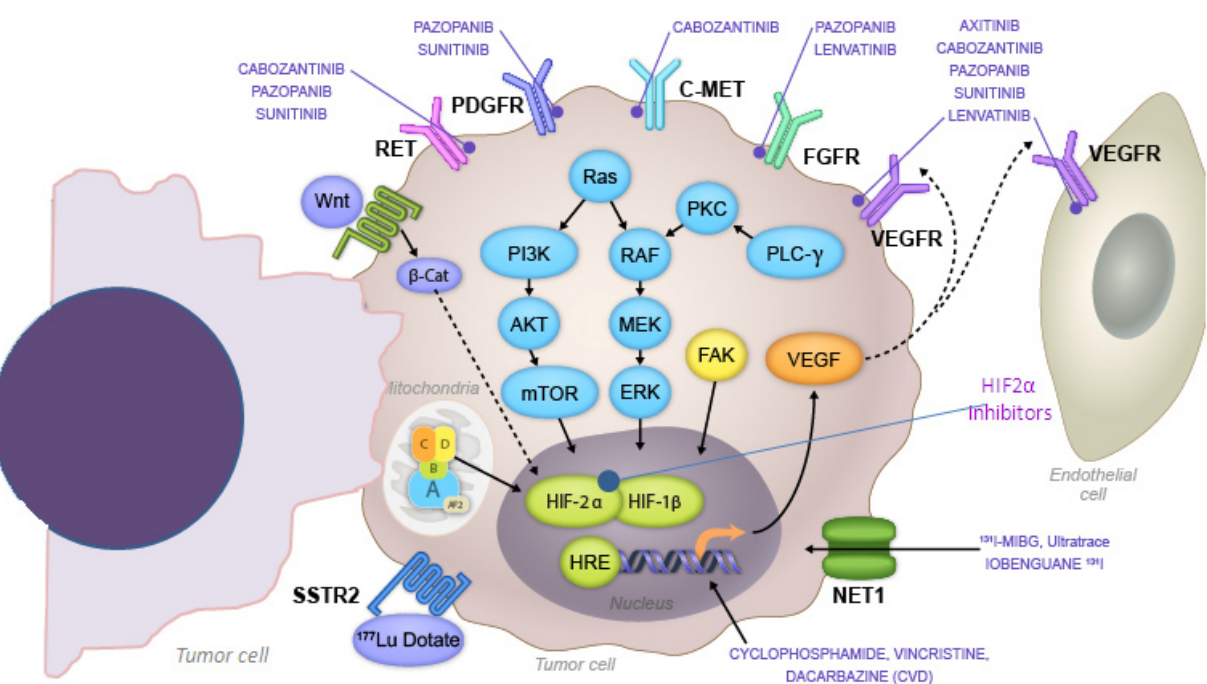
Figure 1. Pharmacodynamics of tyrosine kinase and hypoxia-inducible factor 2 α inhibitors under evaluation in clinical trials for patients with metastatic pheochromocytomas and paragangliomas. This figure includes information on the mechanism of action of systemic chemotherapy and radiopharmaceutical agents: 131 meta-iodo-benzyl-guanidine (MIBG) and 177